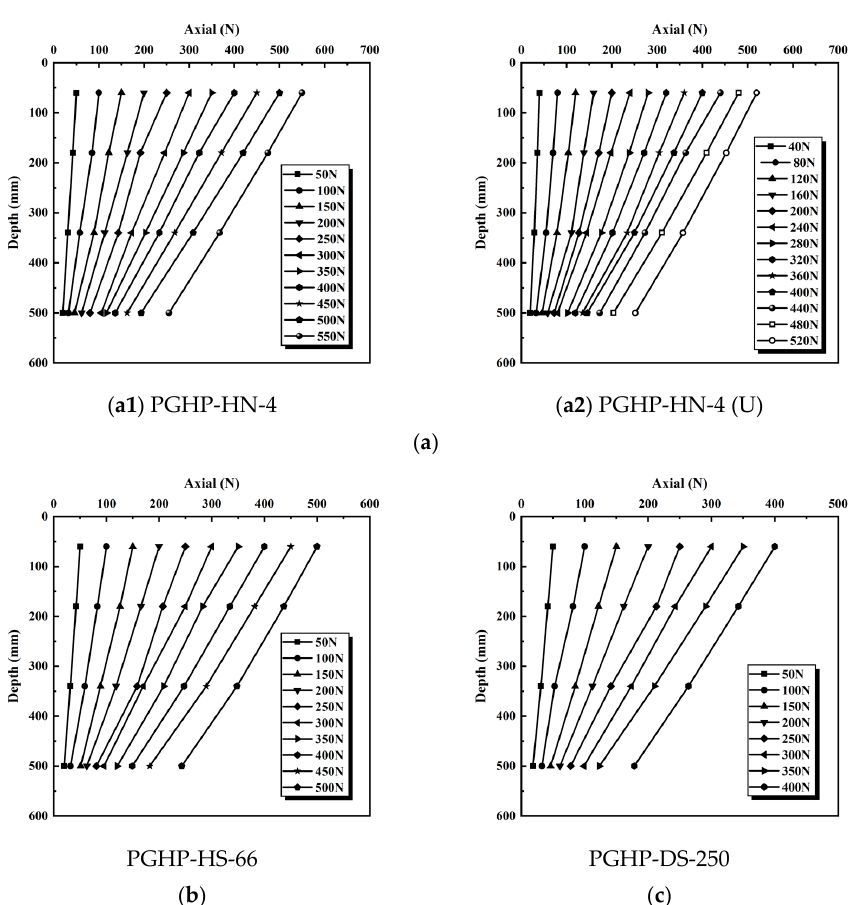
Figure 14. Axial load transfer curves ( a ) helix number test sets, ( b ) helix size test sets, and ( c ) drilling speed test sets.